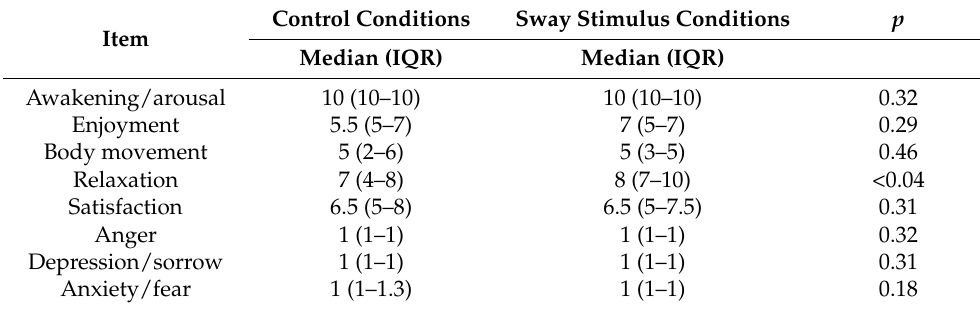
Table 3. Median (interquartile range) and test values of subjective emotion ratings by trial condition.